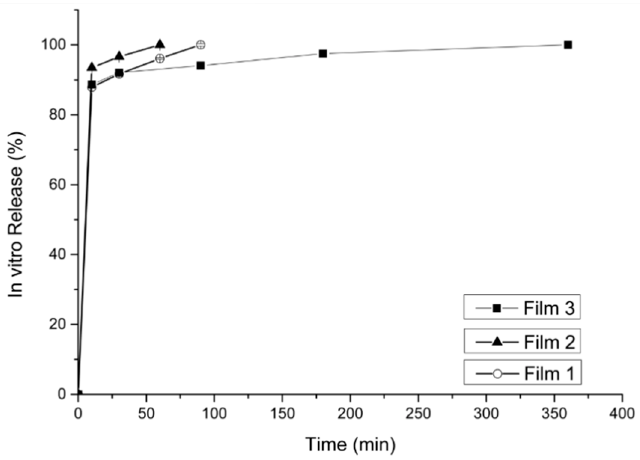
0.25% Eudragit ® RS 12.5.